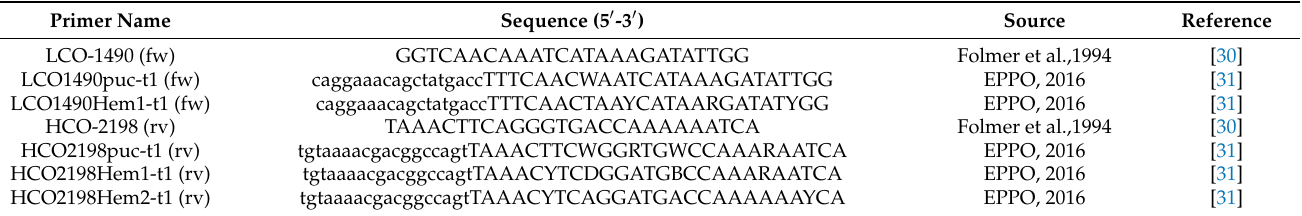
Table 1. List of primers used to amplify the cytochrome c oxidase I (COI) region. Primer